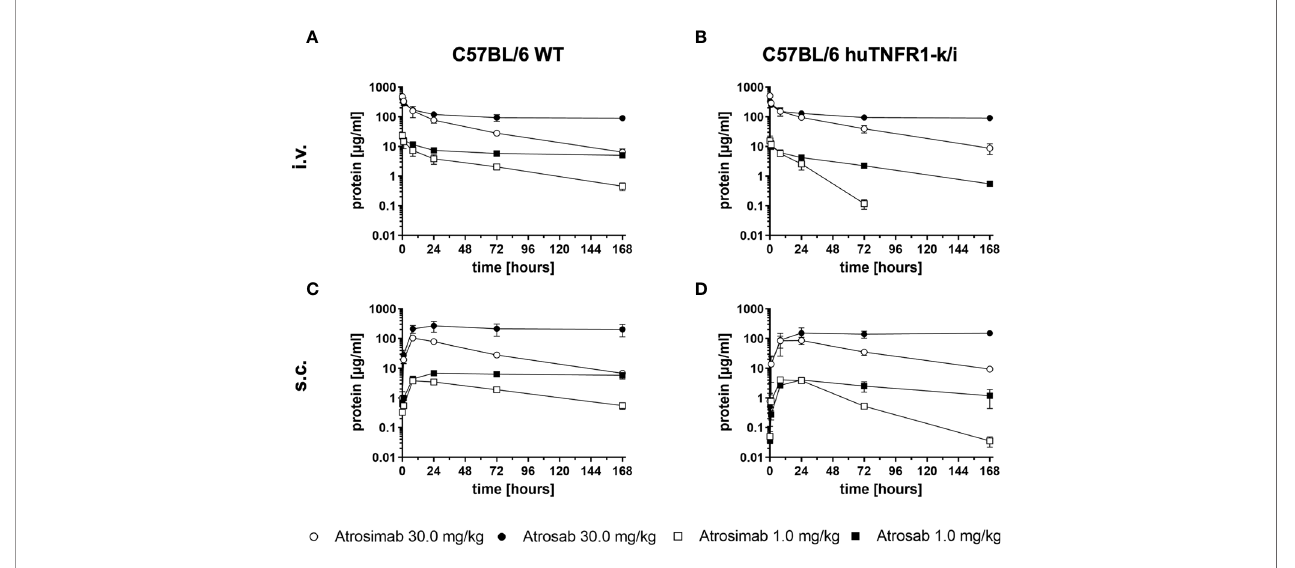
FIGURE 2 | Comparative pharmacokinetic analysis of Atrosimab and ATROSAB. Atrosimab or Atrosab were injected (A, B) intravenously ( i.v. ) or (C, D) subcutaneously ( s.c. ) at doses of 1.0 mg/kg or 30.0 mg/kg body weight into (A, C) C57BL/6 wildtype (WT) or (B, D) C57BL/6 huTNFR1-k/i mice. Serum samples, collected at the indicated time points, were analyzed for remaining circulating protein by ELISA. Shown are the mean ± SD of three